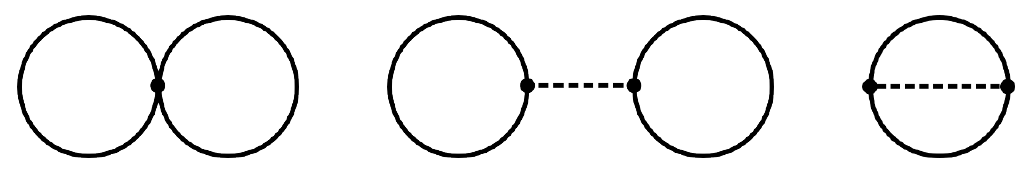
Figure 1 . Two-loop diagrams. Propagators of (cid:18) and ’ are represented by solid and dashed lines